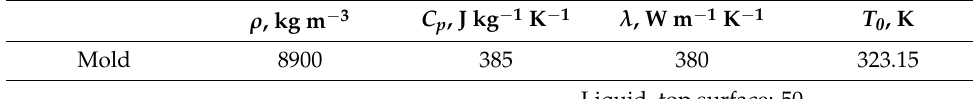
Table 2. The boundary conditions used in the